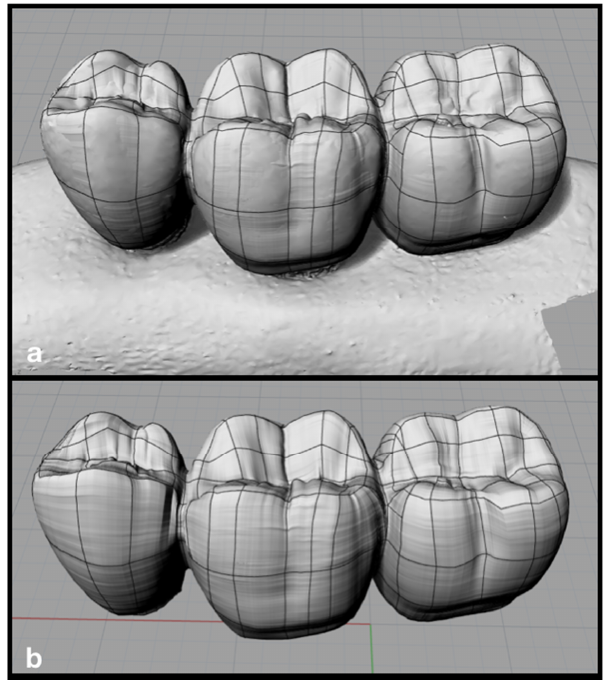
Figure 3. 3D model of the prosthesis made from the “STL” file. Legend: ( a ) lines and meshes over the “STL” file; ( b ) 3D model of the prosthesis.